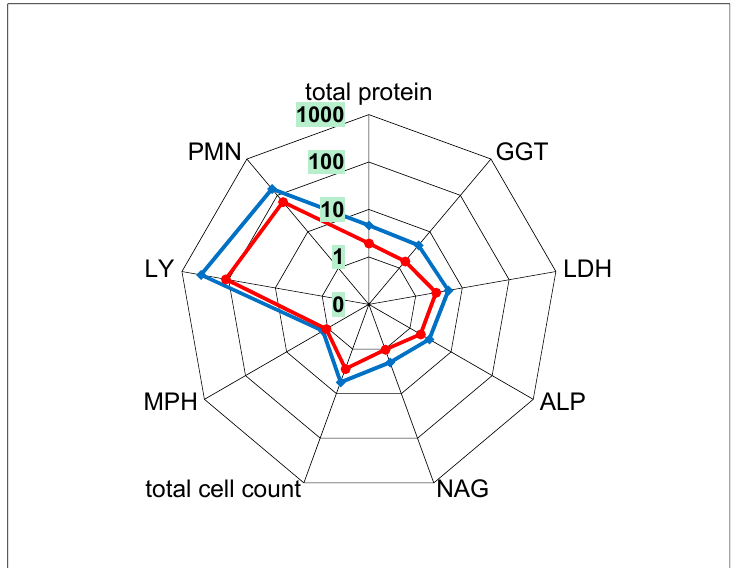
Figure 3. Cell counts, total protein, and enzymes in bronchoalveolar lavage fluid of rats 72 h after single intratracheal instillation of 360 µg 55 nm or 15 nm SiO 2 (from Maser et al. [59]). Blue line: 15 nm SiO 2 ; red: 55 nm SiO 2 . Abbreviations: ALP: alkaline phosphatase; GGT: γ -glutamyltransferase; LDH: lactate dehydrogenase; LY: absolute cell count for lymphocytes; MPH: absolute cell count for macrophages; PMN: absolute cell count for polymorphonuclear neutrophilic granulocytes; NAG: N -acetyl- β -glucosaminidase.